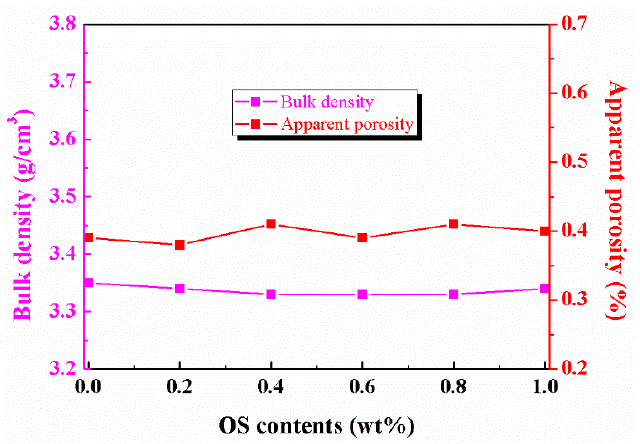
Figure 8. Bulk density and apparent porosity of AlN ceramics prepared with modi fi ed AlN powder